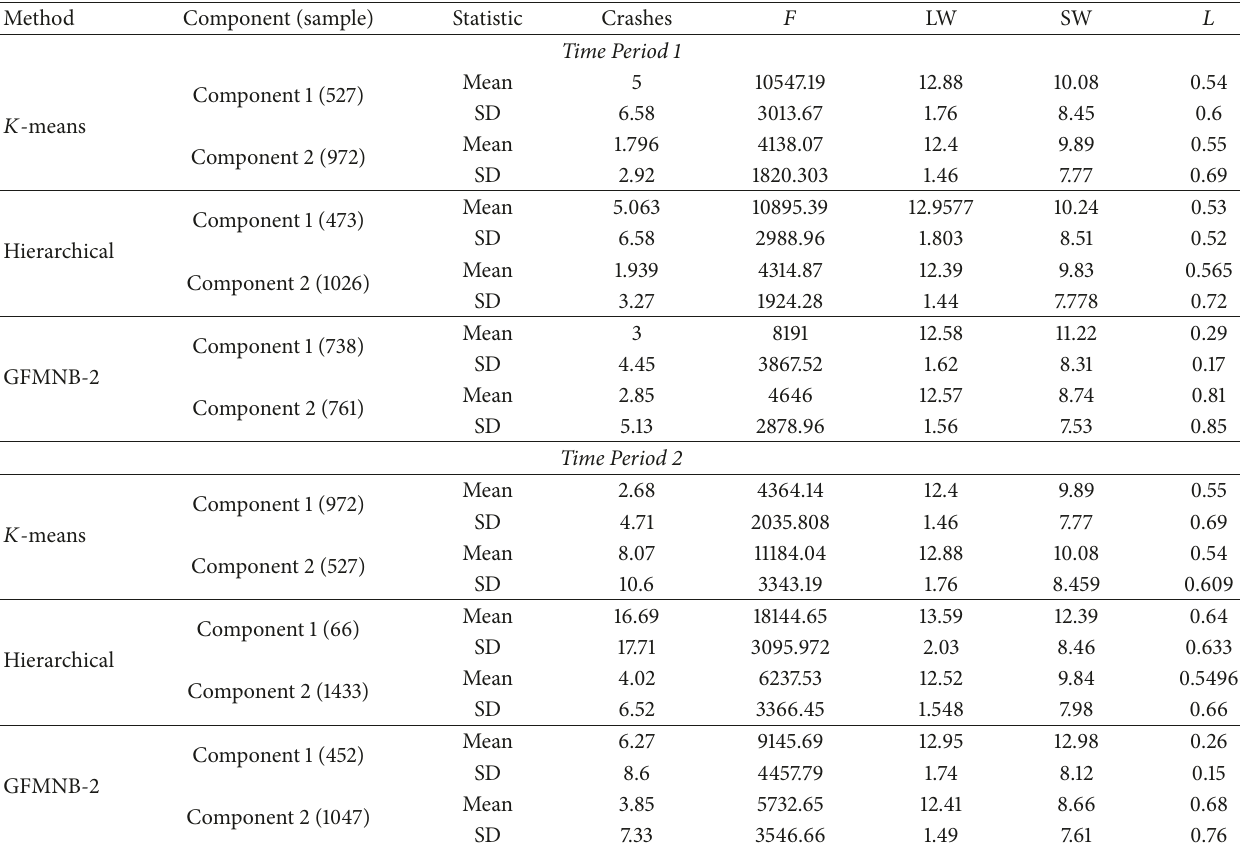
Table 3: Characteristics of each